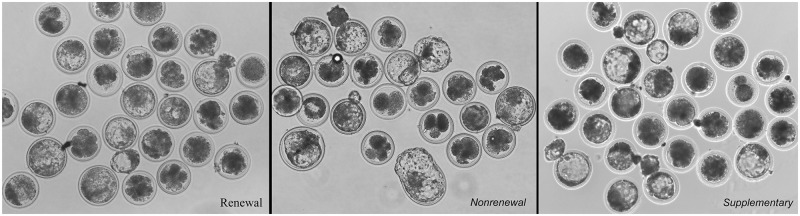
Representative photographs of bovine SCNT blastocysts derived from renewal, nonrenewal, and supplementary groups.